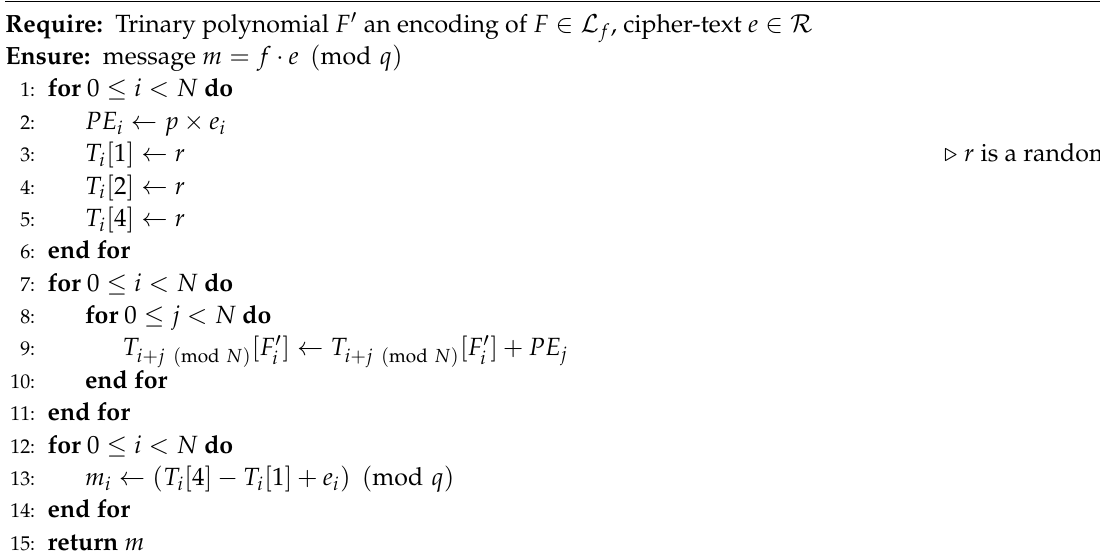
Algorithm 5 Countermeasure Applied Decryption of